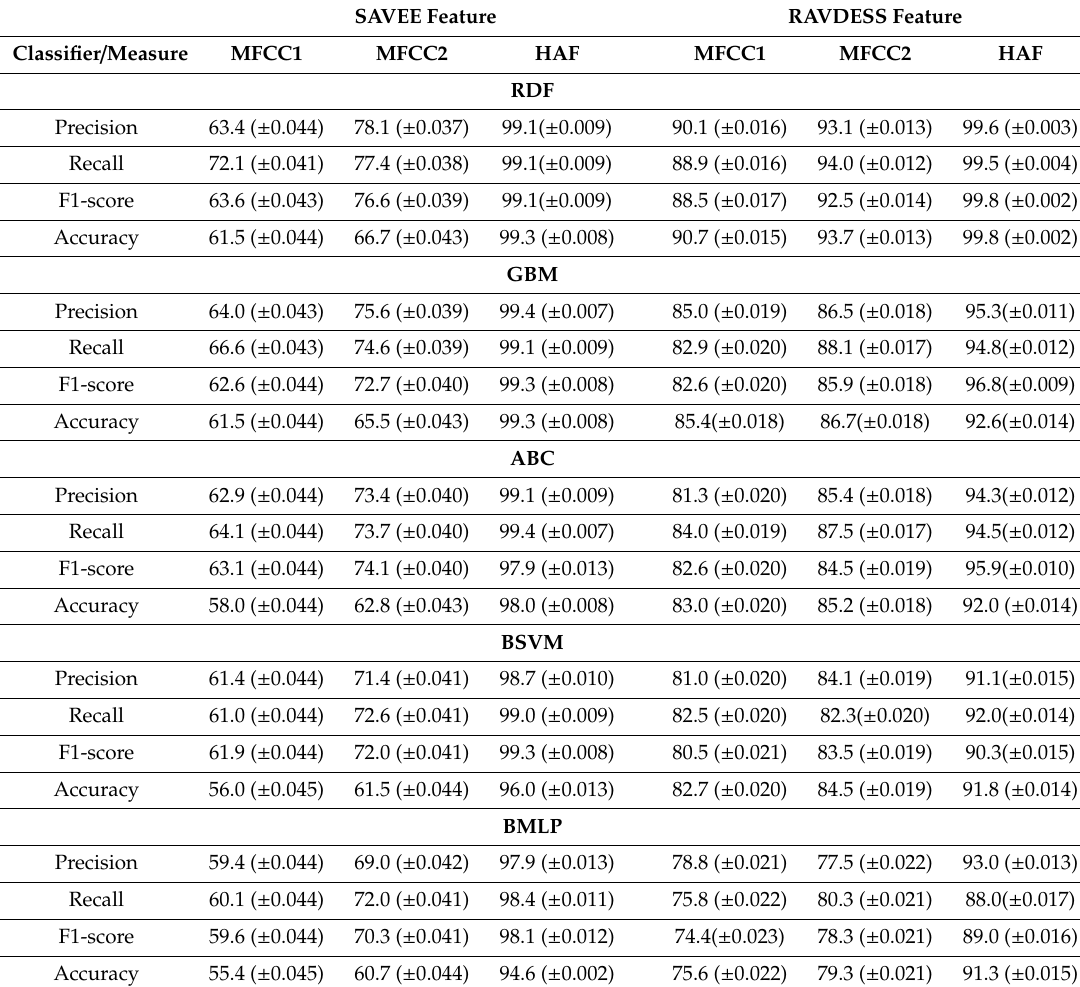
Table 4. Percentage average precision, recall, F1-score and accuracy with confidence intervals of learning algorithms trained with MFCC1, MFCC2 and